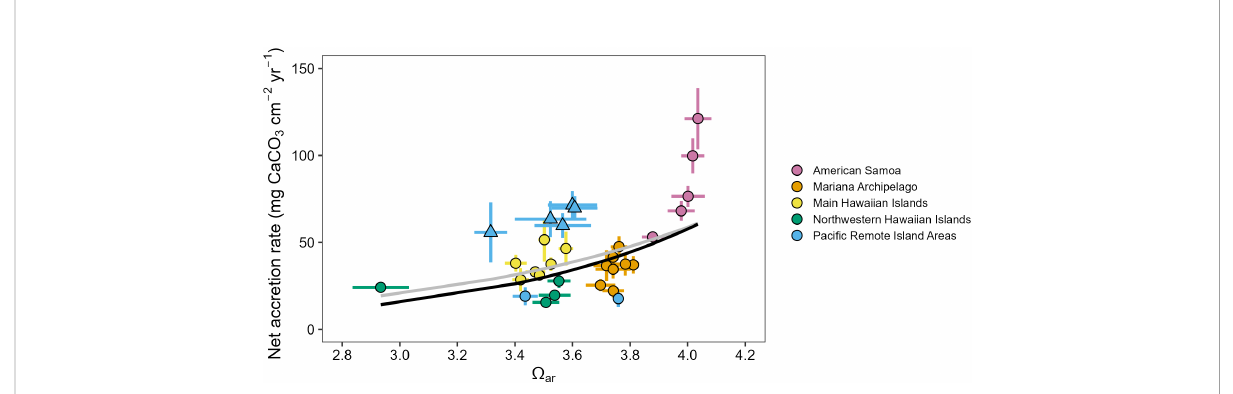
FIGURE 5 Mean (± standard error) in situ W ar plotted against mean net calcium carbonate accretion rates measured from Calci fi cation Accretion Units (CAUs) for 31 Paci fi c Islands from 2010 – 2019, shown with signi fi cant fi tted exponential relationships between W ar and accretion rates for all islands (gray line) and with equatorial and near-equatorial Paci fi c Remote Island Areas (triangles) removed (black